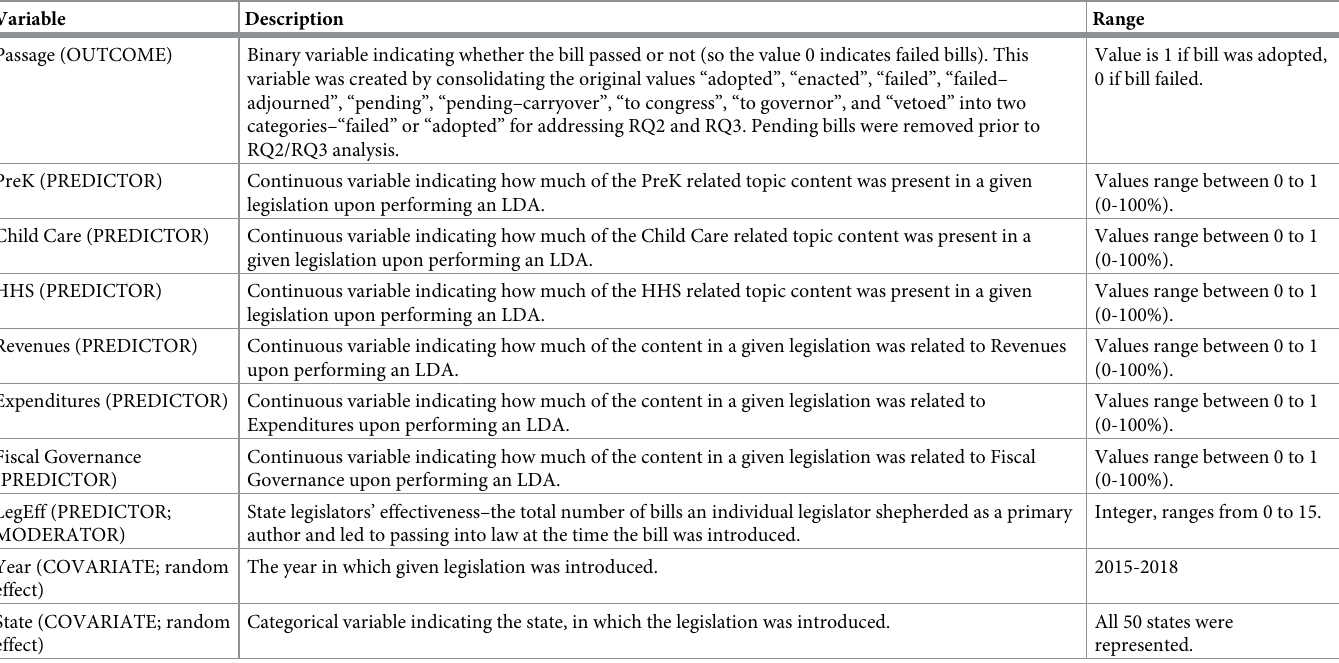
Table 1. Variables used in our analysis classified into outcomes, predictors, and controls and followed by their description and range of values they attain. Variable Description Passage